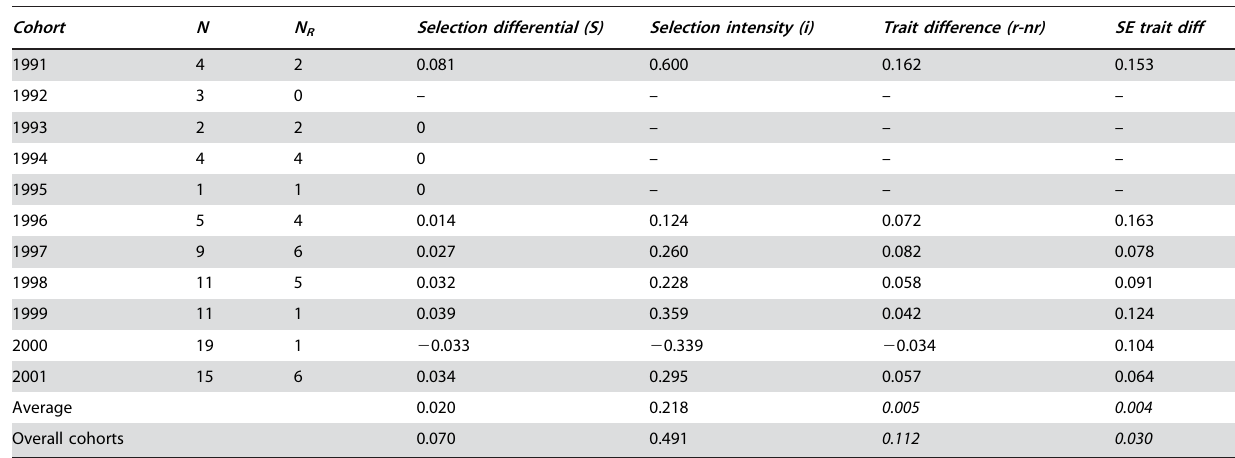
Table 1. Selection differential (S) and selection intensity ( i ) on standardized heterozygosity and trait differences between wolves recruited (r) and not recruited (nr) to the breeding population. .. ... .... ... ... .... ... ... .... ... ... .... ... ... .... ... ... .... ... ... .... ... ... .... ... ... .... ... ... .... ... ... .... ... ... .... ... ... .... ... ... .... ... ... . Cohort N N